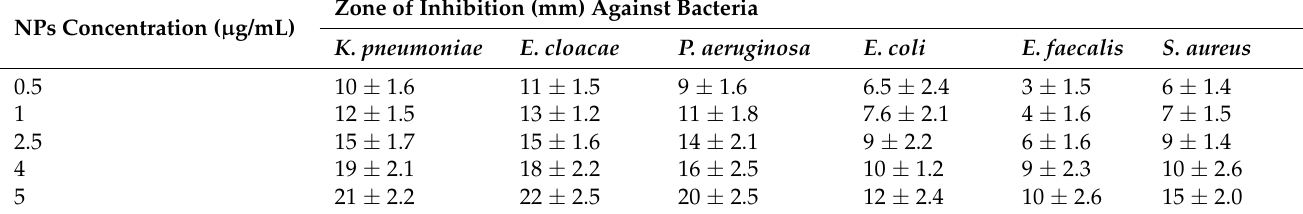
Table 1. Antibacterial activity (as the zone of inhibition, mean ± SD, n = 3) of Ag-Cu NPs against six bacterial species.